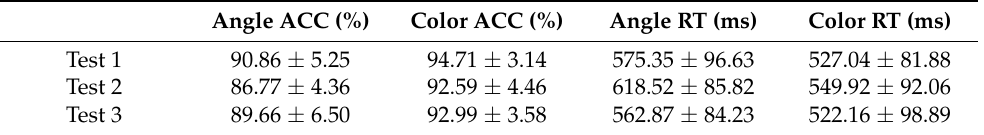
Table 2. Behavior results in Tests 1/2/3.